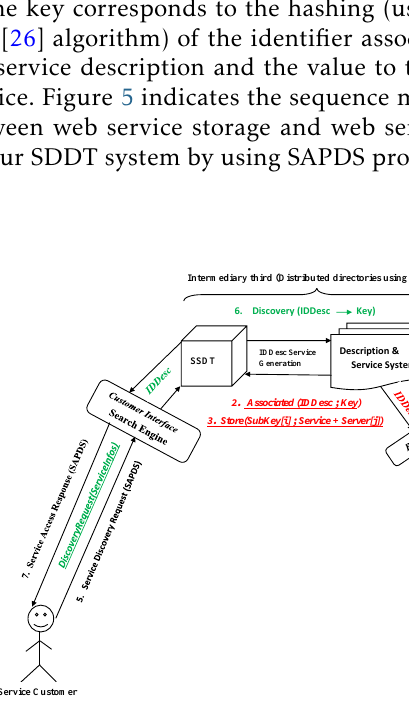
Figure 5. Use case for Service Storage and Discovery.